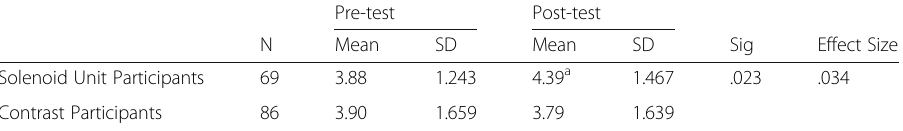
Table 2 One-way repeated measures ANOVA comparing means across groups on the TIMSS-L Pre-test